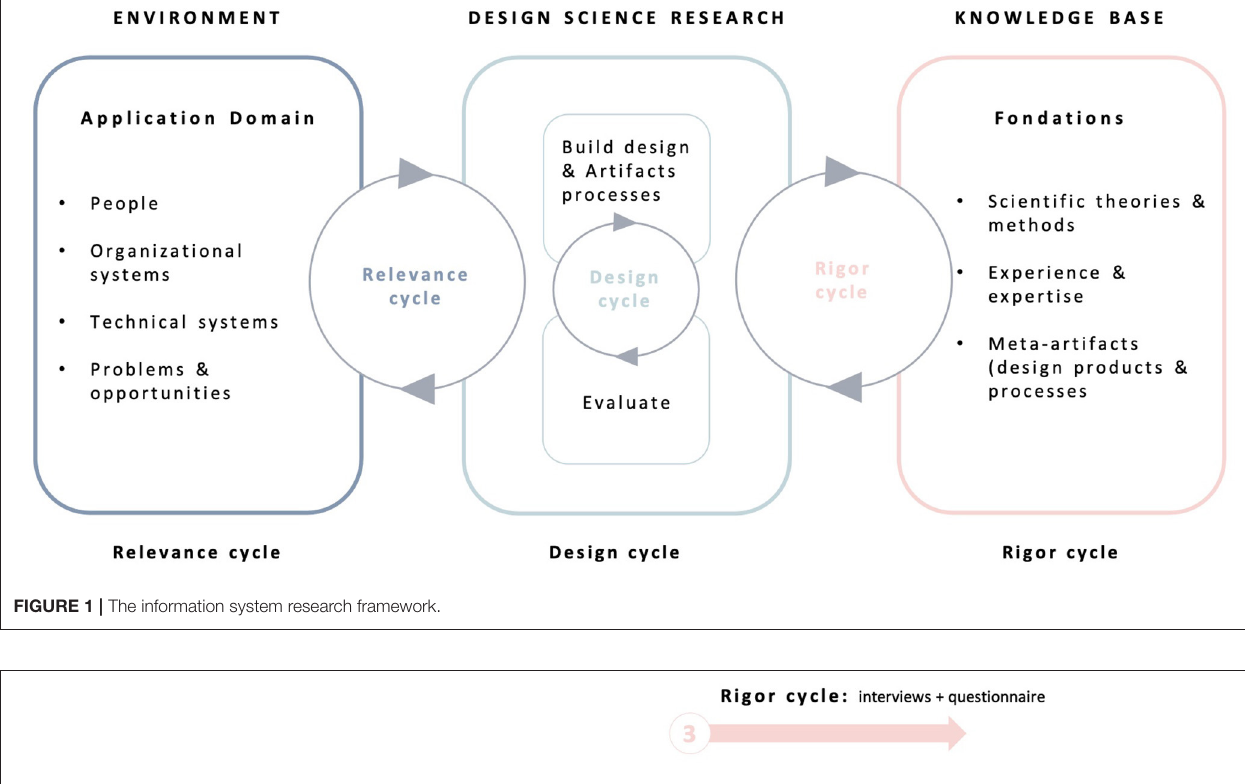
FIGURE 1 | The information system research framework.